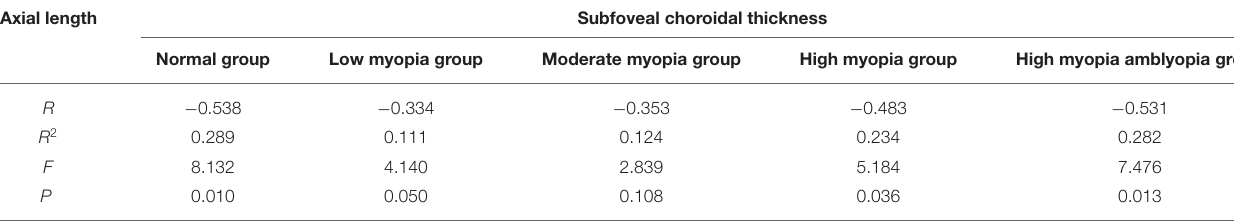
TABLE 8 | Correlation between subfovea choroidal thickness and axial length in each group. Axial